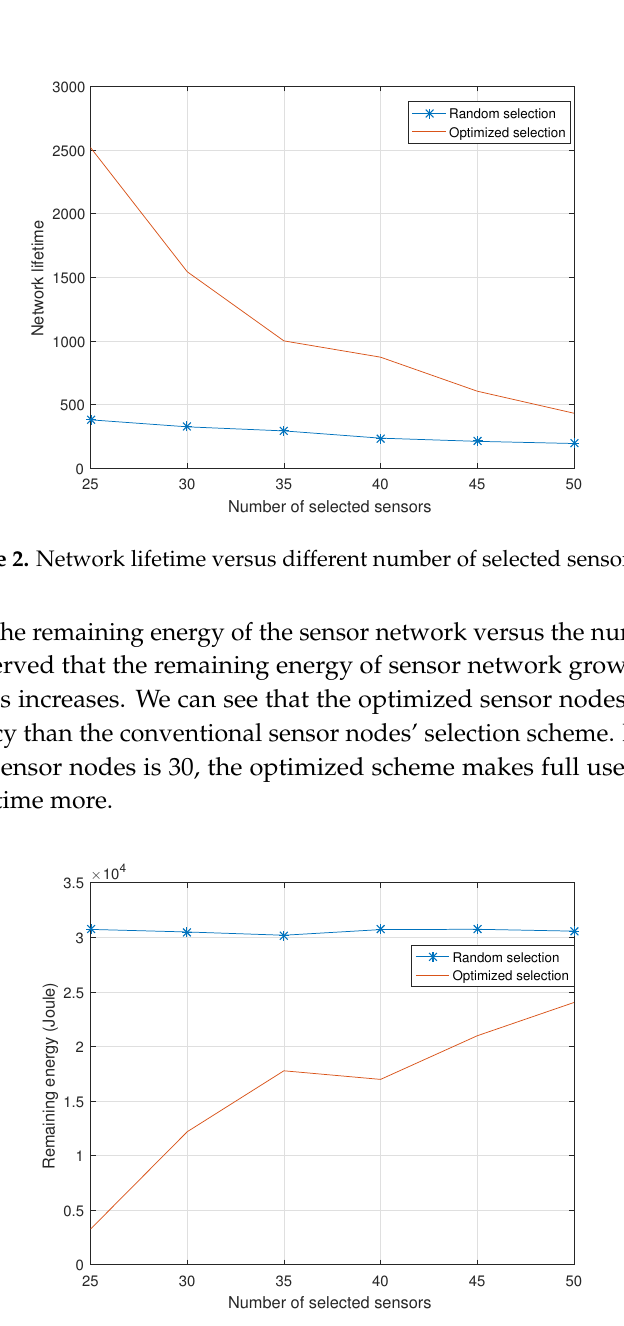
Figure 3. Remaining energy versus different number of selected sensor